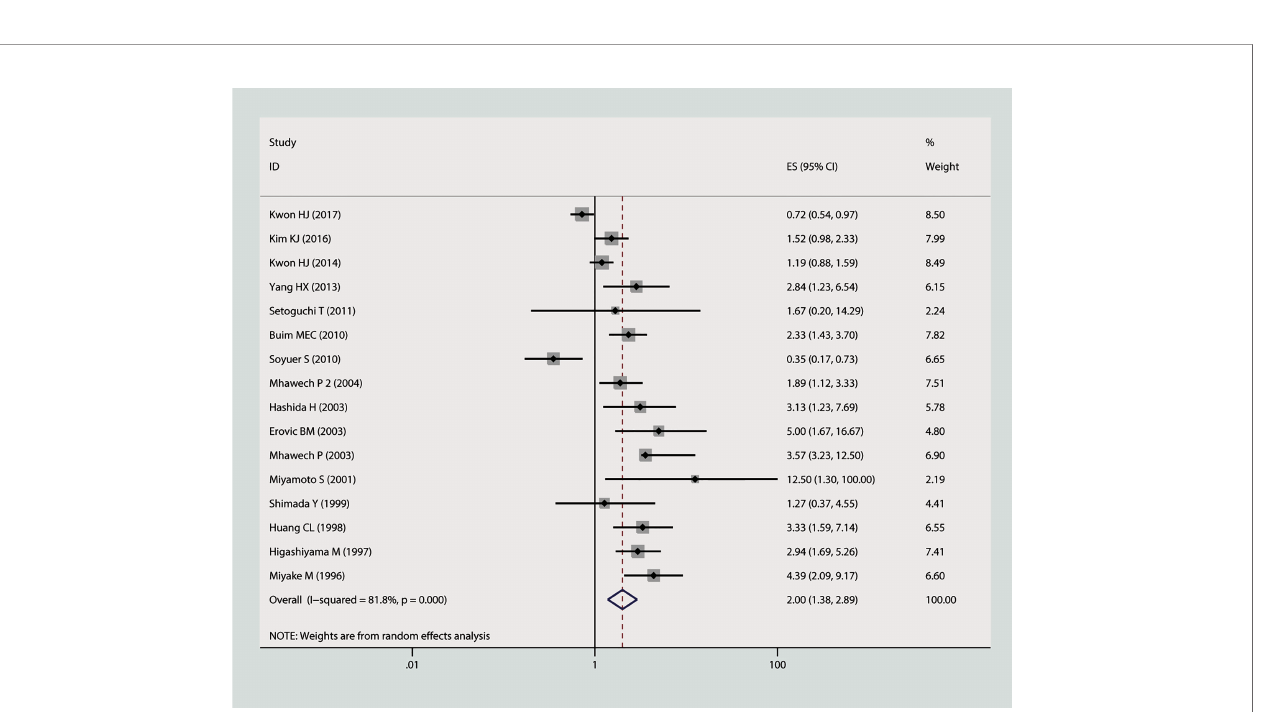
FIGURE 3 | The connection between CD9 expression and time to progression (TTP) in solid